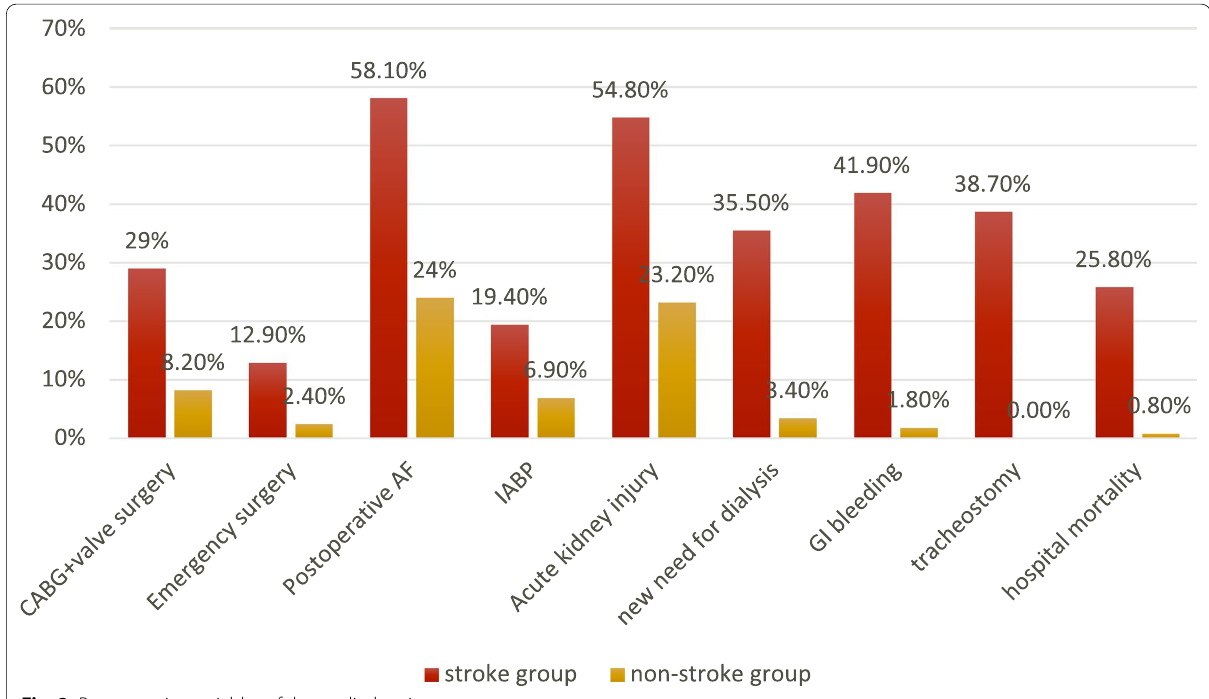
Fig. 2 Postoperative variables of the studied